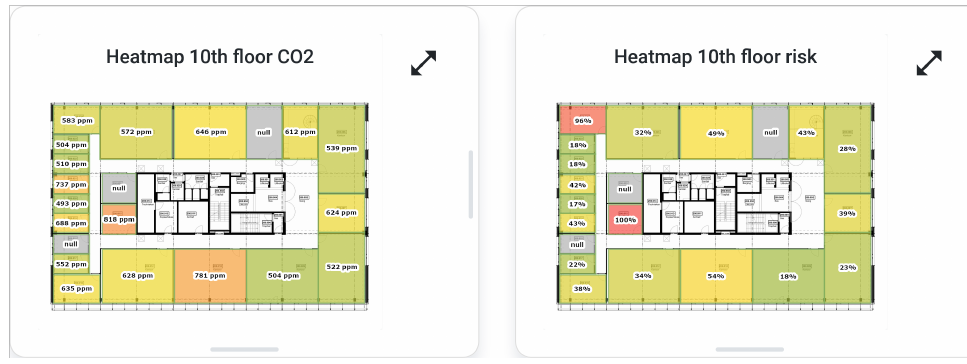
Figure 5. Heatmap visualization of the CO 2 concentration and COVID-19 aerosol transmission risk estimation of the 10th floor of our office building.